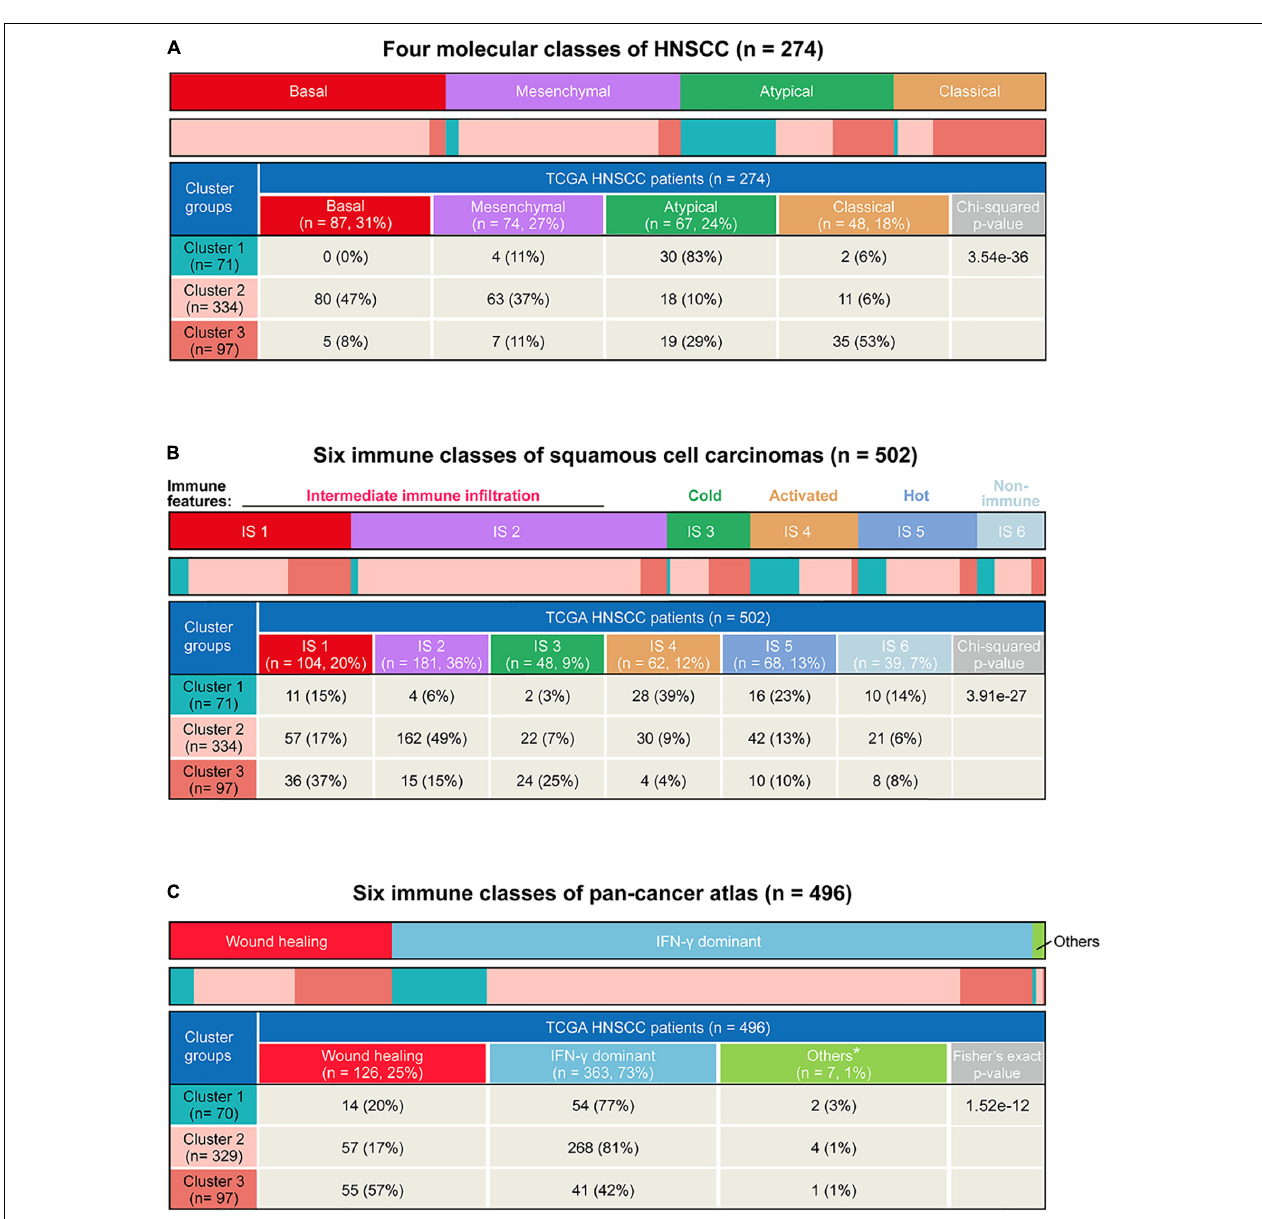
FIGURE 7 | Comparison of the three subtypes in our study with existing immune and molecular classes. (A) Heatmap and table showing distribution of four head and neck squamous cell carcinoma (HNSCC) molecular classes (basal, mesenchymal, atypical, and classic) in different subtypes. (B) Heatmap and table showing the distribution of pan-squamous cell carcinomas (SCC) immune classes (IS1, IS2, IS3, IS4, IS5, and IS6) between the three subtypes. (C) Heatmap and table showing distribution of six pan-cancer immune classes in different subtypes. *Other immune classes include inflammatory, lymphocyte depleted, immunologically quiet, and TGF- β